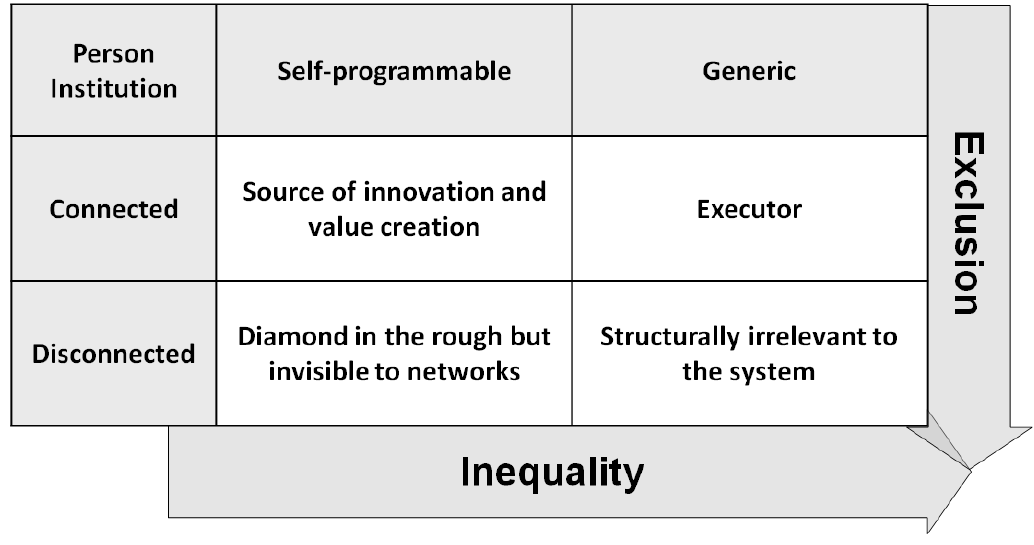
Figure 7: Factors of inequality and exclusion in the Network Society